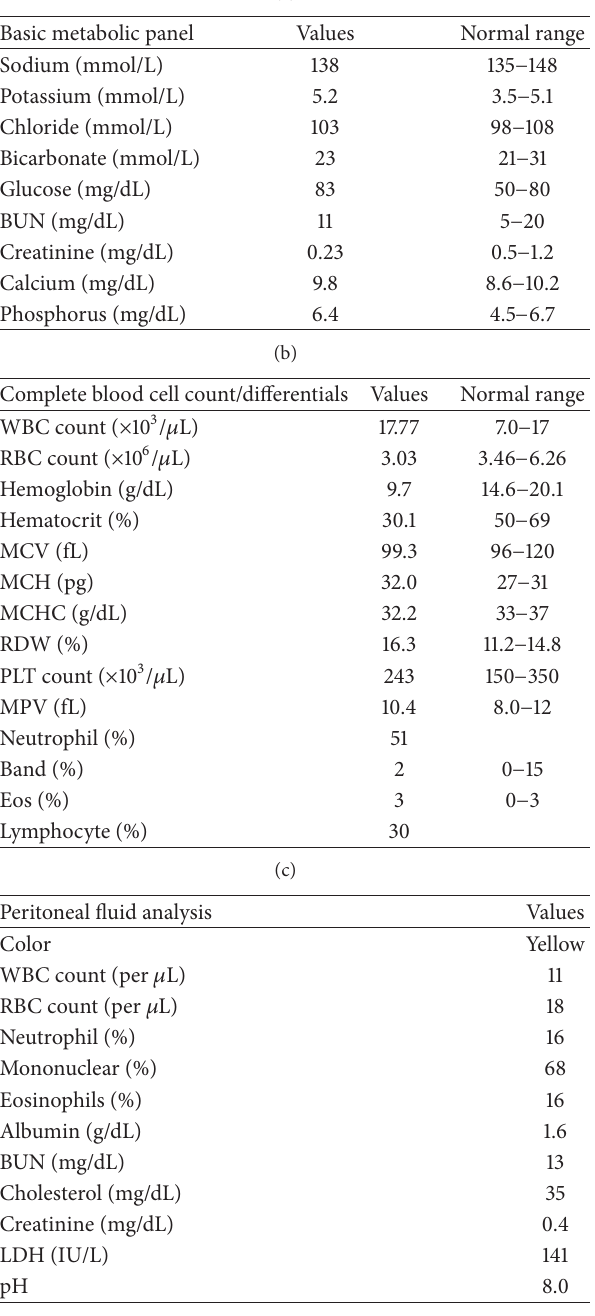
Table 1: Admission labs and peritoneal fluid